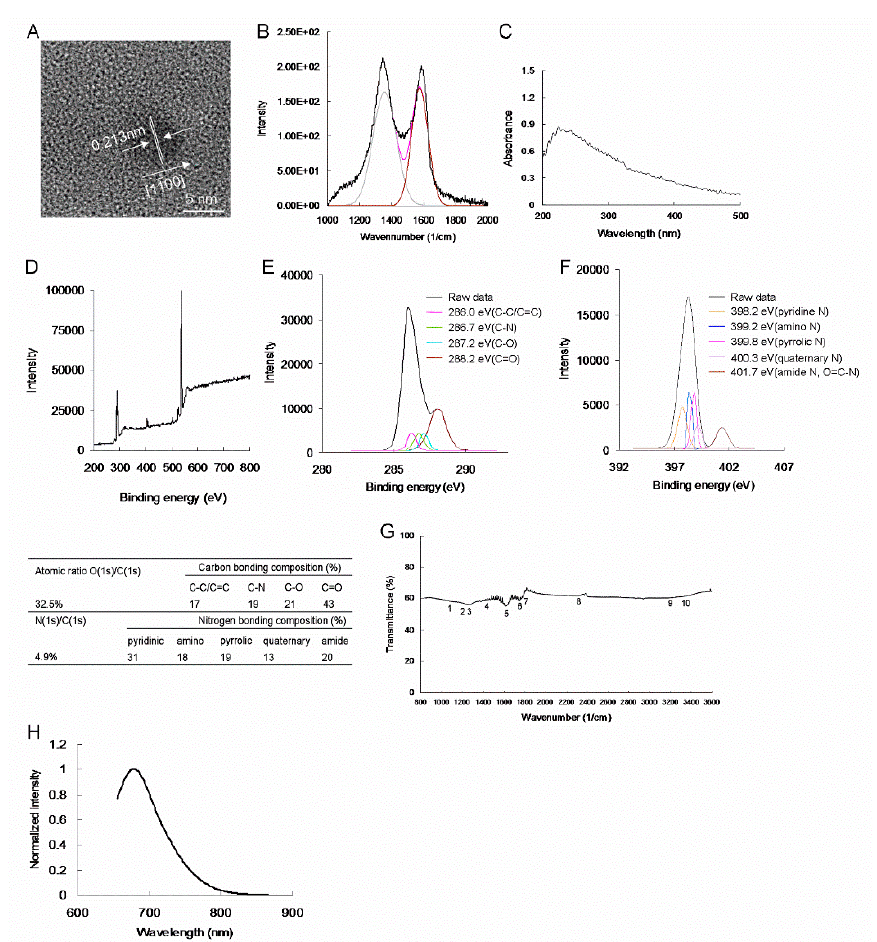
Figure 2. ( A ) HR-TEM image obtained for a single amino-N-GQD (4.9%), which exhibited graphene {1 100} lattice planes, a mean lateral size of 7.1 ± 0.7 nm, and a d -spacing of 0.213 nm. ( B ) Raman spectroscopy results indicating the material’s crystallinity. The gray and brown lines indicate that the spectrum was decomposed and fitted into the D-band (~1385 cm − 1 ) and G-band (~1607 cm − 1 ) peaks (black line: raw data; pink line: decomposed spectrum). The I D / I G ratio was approximately 0.89. ( C ) UV–Vis spectrum of the material (peak at 223 nm corresponded to the π – π * transition of aromatic C = C bonds and the n– π * transitions of the C–N and C = O shoulder appeared at approximately 326 nm). ( D ) Full-range XPS results for the material. ( E , F ) Peaks fitted using a Gaussian function for the deconvoluted C(1s) and N(1s) XPS spectra. The peaks of a nonoxygenated ring (C–C / C = C, 286.0 eV) as well as those of C-N (286.7 eV), hydroxyl (C–O, 287.2 eV), and carbonyl (C = O, 288.2 eV) bonds were fitted using a Gaussian function for the deconvoluted C(1s) XPS spectra. The peaks of pyridinic N (398.2 eV), amino N (NH 2 , 399.2 eV), pyrrolic N (399.8 eV), quaternary N (400.3 eV), and amide N (O = C–N, 401.7 eV) were fitted using a Gaussian function for the deconvoluted N(1s) XPS spectra. The atomic ratios and binding compositions for the amino-N-GQD (4.9%) are summarized in the table. O (1s) / C (1s) and N (1s) / C (1s) atomic ratios were 32.5% and 4.9%, respectively. ( G ) FTIR spectrum of the material. For the amino-N-GQD (4.9%), the results revealed characteristic bands at approximately 1053 cm − 1 (band 1), corresponding to C—O stretching; approximately 1194 cm − 1 (band 2), corresponding to C—N stretching; approximately 1228 cm − 1 (band 3), corresponding to N—C = O stretching; approximately 1421 cm − 1 (band 4), corresponding to tertiary alcoholic C-OH bending; approximately 1609 cm − 1 (band 5), corresponding to a C = C ring; approximately 1755 cm − 1 (band 6), corresponding to N—H bending and amide; approximately 1813 cm − 1 (band 7), corresponding to C = O stretching; approximately 2349 cm − 1 (band 8), corresponding to N—H stretching; t approximately 3218 cm − 1 (band 9), corresponding to C—H stretching; and approximately 3325 cm − 1 (band 10), corresponding to N—H vibration. ( H ) Fluorescence spectrum of the material (Ex / Em: 630 nm / 678